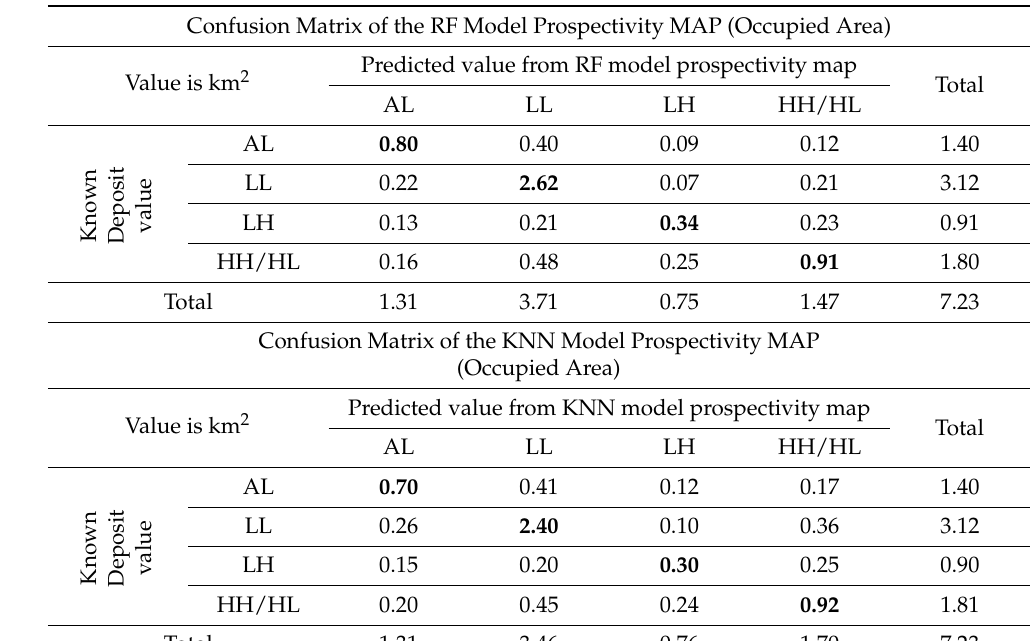
Figure 10. Geology and prospectivity map for Nb ‐ Ta placer deposits generated with the final ( a ) IDW ‐ weighted KNN model and ( b ) RF (30 sp/100L) model (blue pyramids are known occurrences outside the granite schist shear zone, and black pyramids are those inside the shear zone). Table 9. Sensibility and specificity results of RF and KNN prospectivity models. The best performing metric values that were calculated per class is shown in bold